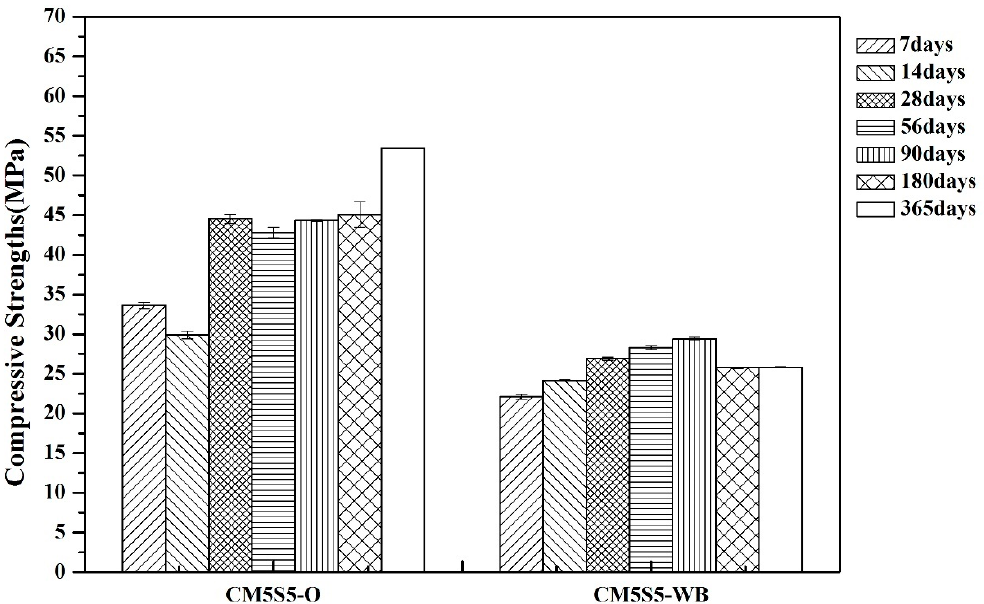
Figure 9. Compressive strength of marble-based geopolymer concrete produced with recycled aggregate.